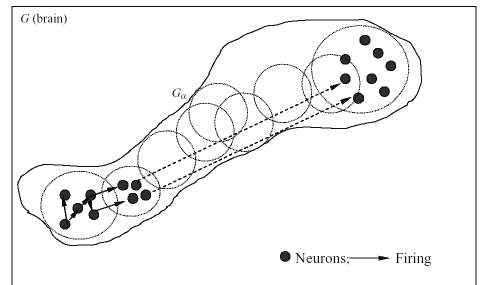
Fig. 3. Schematic diagram illustrating information propagation.